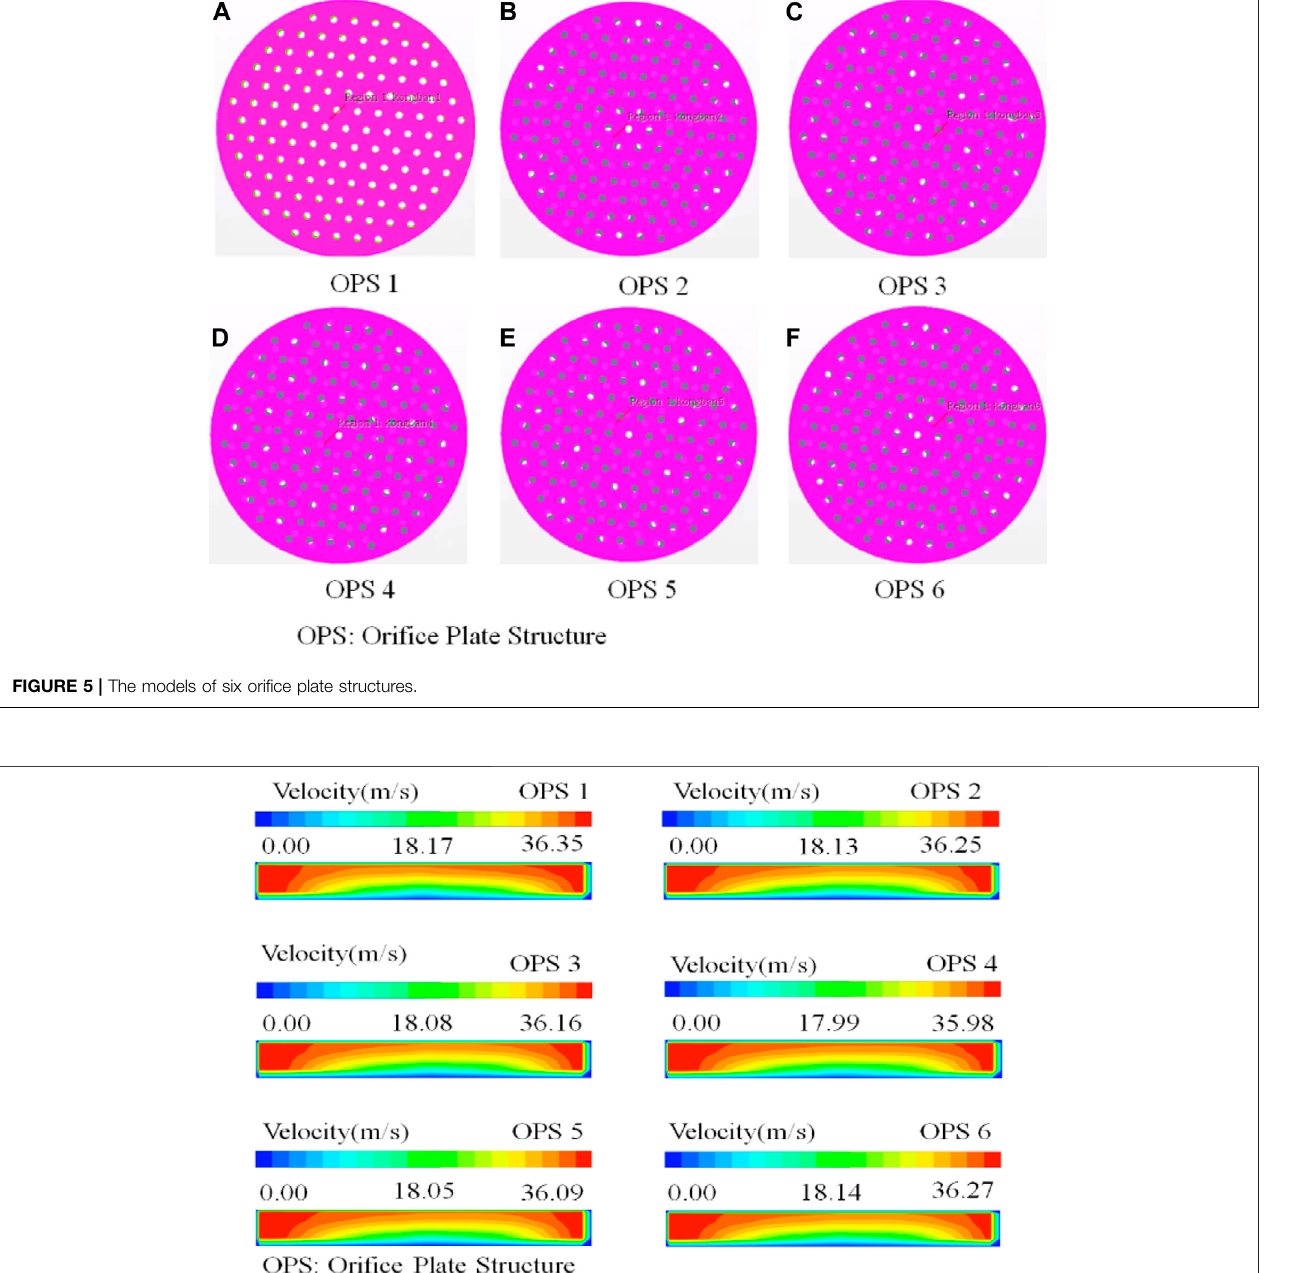
Frontiers in Energy Research |